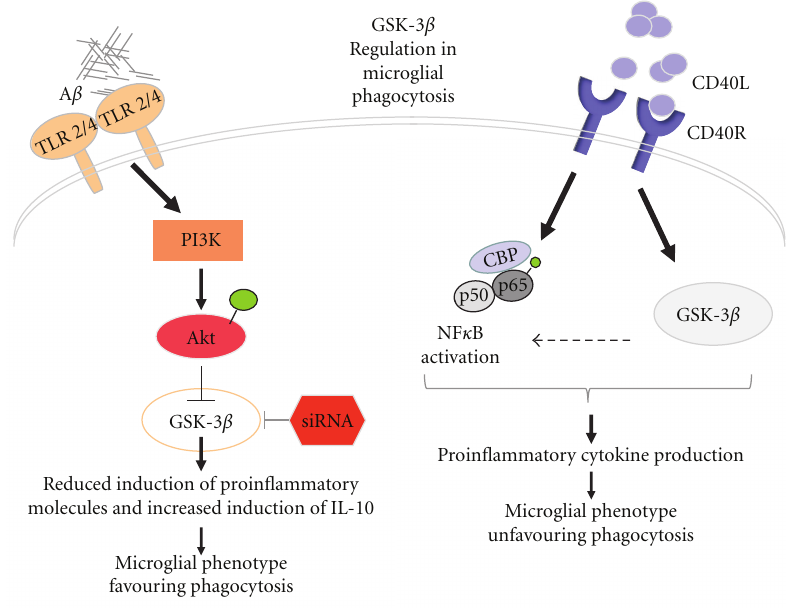
Figure 2: GSK-3 β in the regulation of microglial phagocytosis. Microglial phagocytosis has been shown to be enhanced through activation of TLR2/4 pathway. Binding of A β to TLR2/4 may result in activation of PI3K signalling eventually leading to inhibition of GSK-3 β activation. This in turn shifts the cellular balance towards increase in the production of antiinflammatory cytokines favouring phagocytic microglial phenotype. On the other hand, CD40R-CD40L interaction results in both NF- κ B and GSK-3 β activation thus increasing proinflammatory cytokine production. This may shift the phenotype of microglial cells being less capable of clearing A β